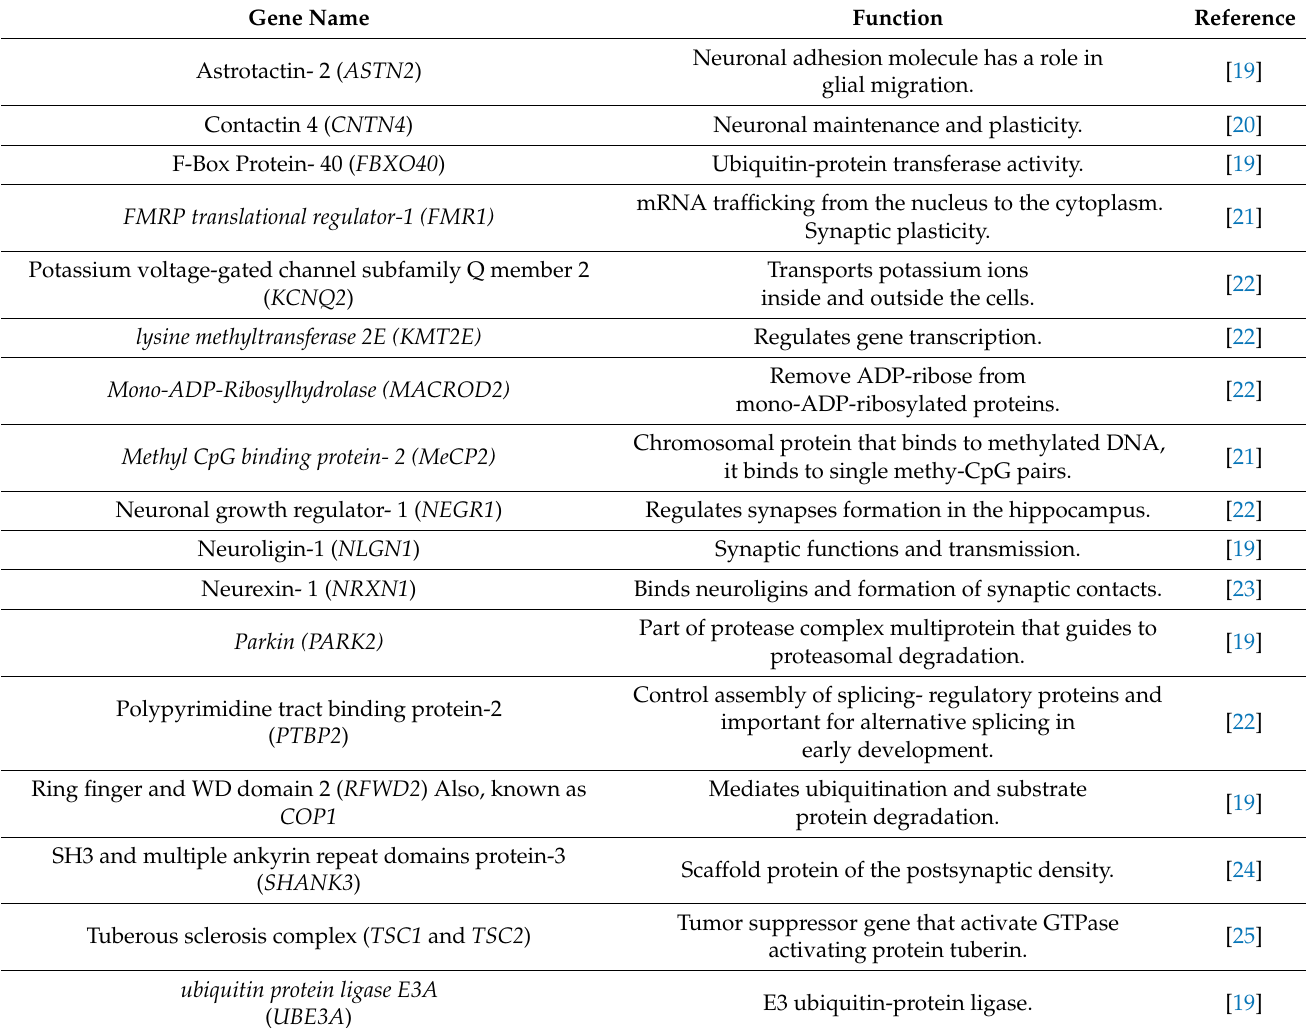
Table 1. Genes associated with autism spectrum disorder